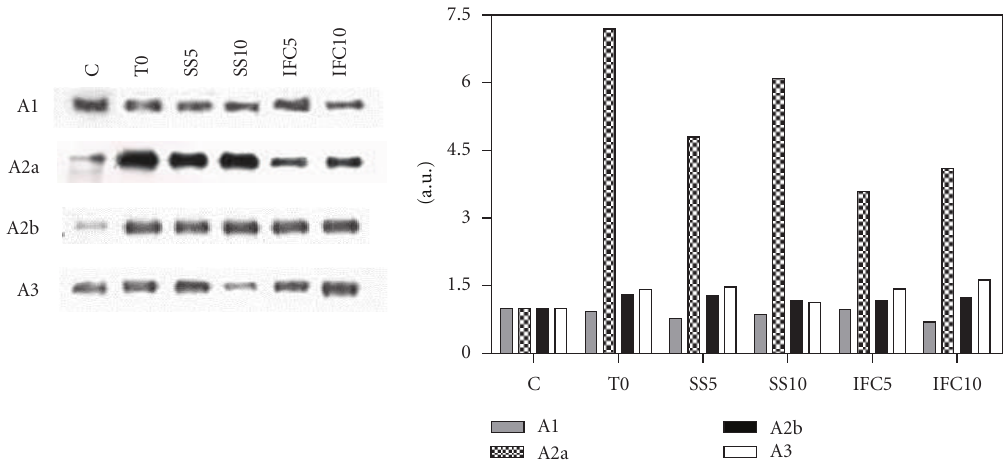
Figure 7: E ff ect of IFC305 treatment on adenosine receptors expression in CCl 4 -induced cirrhosis in rats. Expression of the indicated adenosine receptors from liver extracts was done by western blot analysis. A representative western blot image of each one is shown. The bar graph represents the densitometry analysis expressed as arbitrary units of the mean ± SEM from 3rats/group; values were normalized to β -actin immunodetection (image, Figure 1(a)).